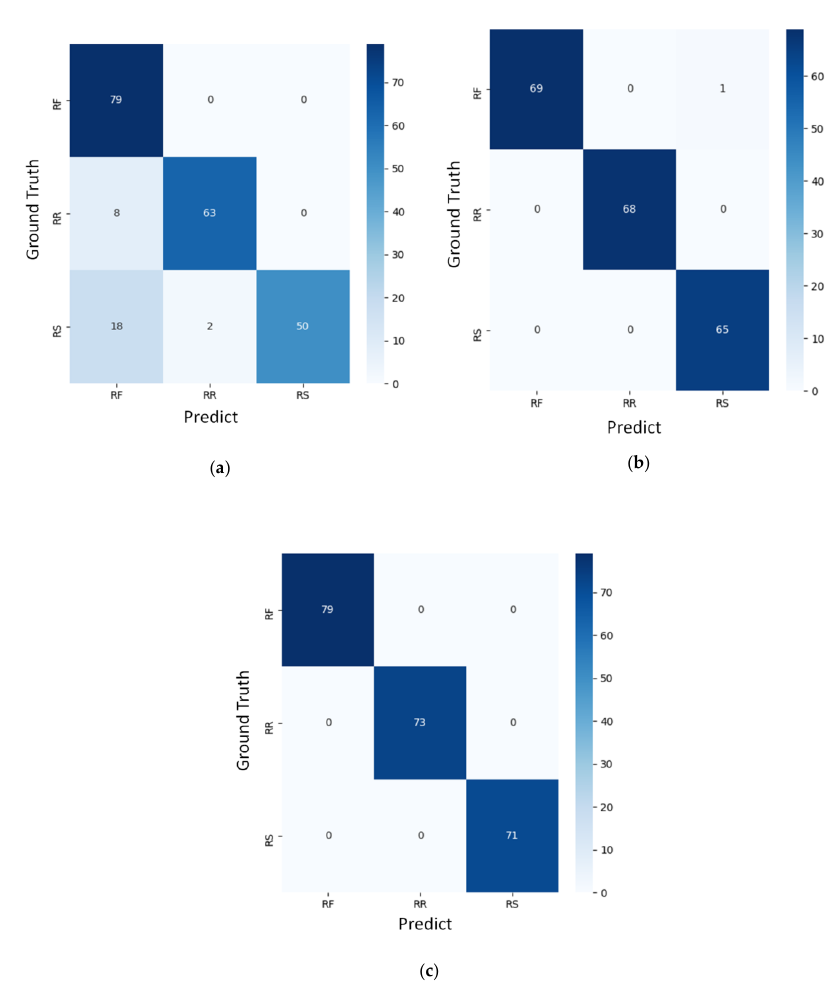
Figure 8. The confusion matrix of the faster region-based convolutional network (Faster R-CNN), single-shot multibox detector (SSD), and You Only Look Once v4 (YOLO v4) models for scale pest recognition. ( a ) Faster R-CNN. ( b ) SSD. ( c ) YOLO v4.